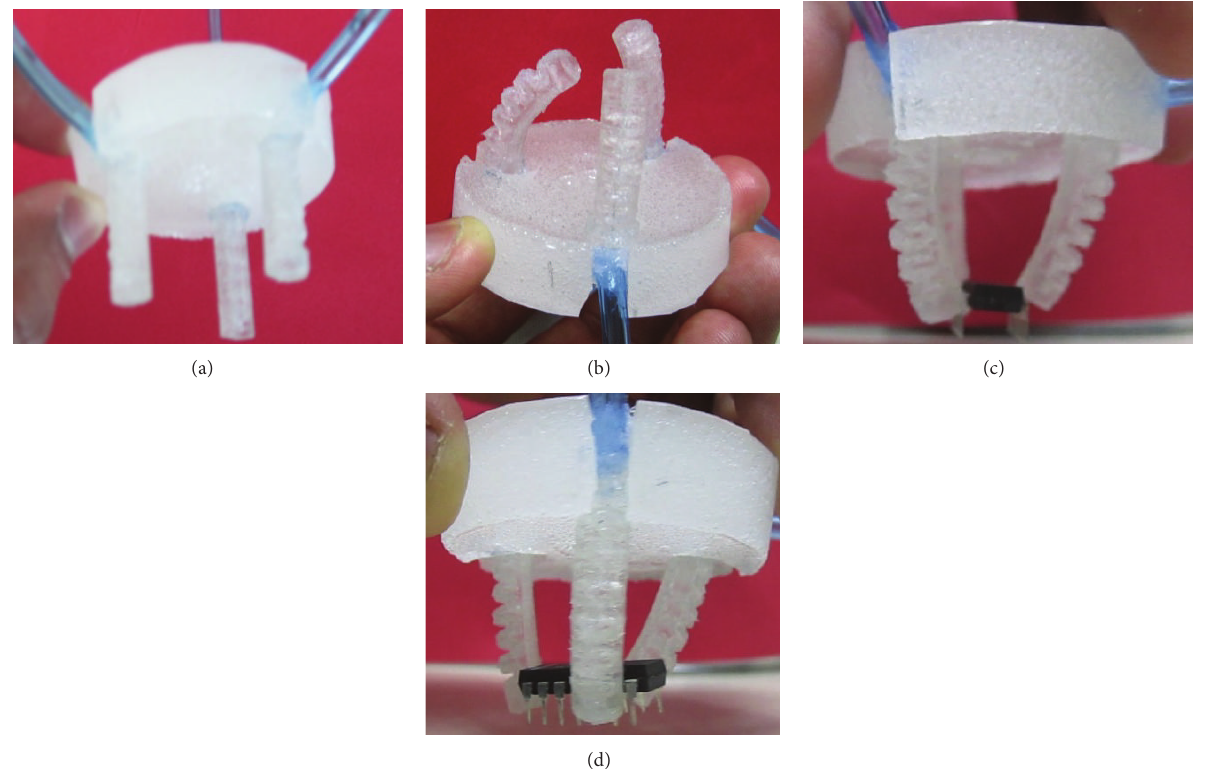
Figure 20: Miniature soft grippers: (a) without application of pressure, (b) with application of pressure, (c) grasping IC chip, and (d) grasping up IC